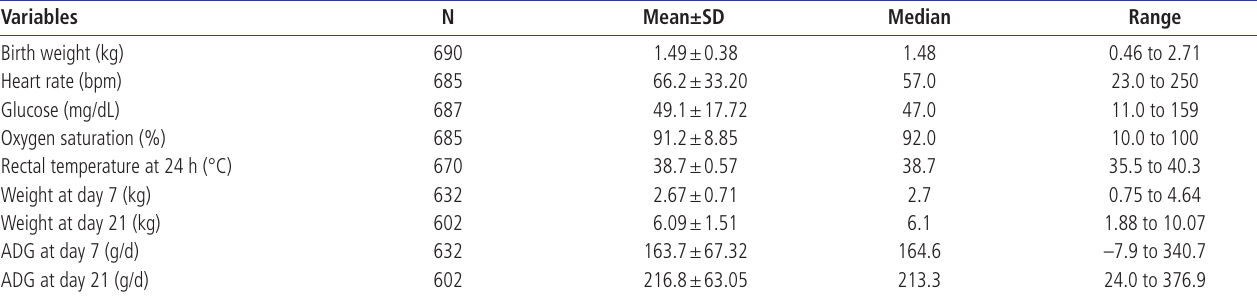
Table 1. Descriptive statistics of 690 piglets evaluated at birth and during the lactation period Variables